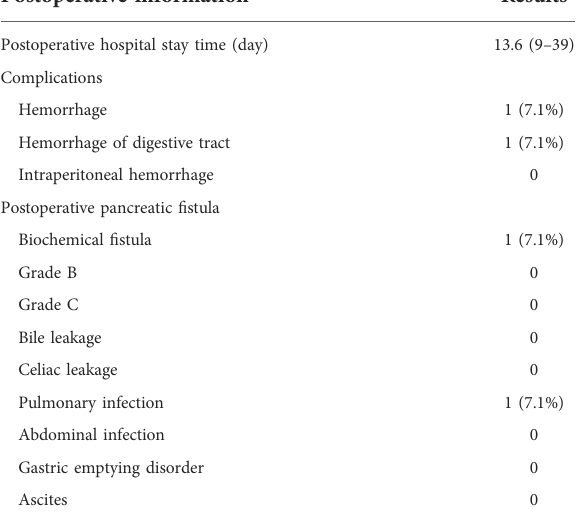
TABLE 3 Postoperative results.